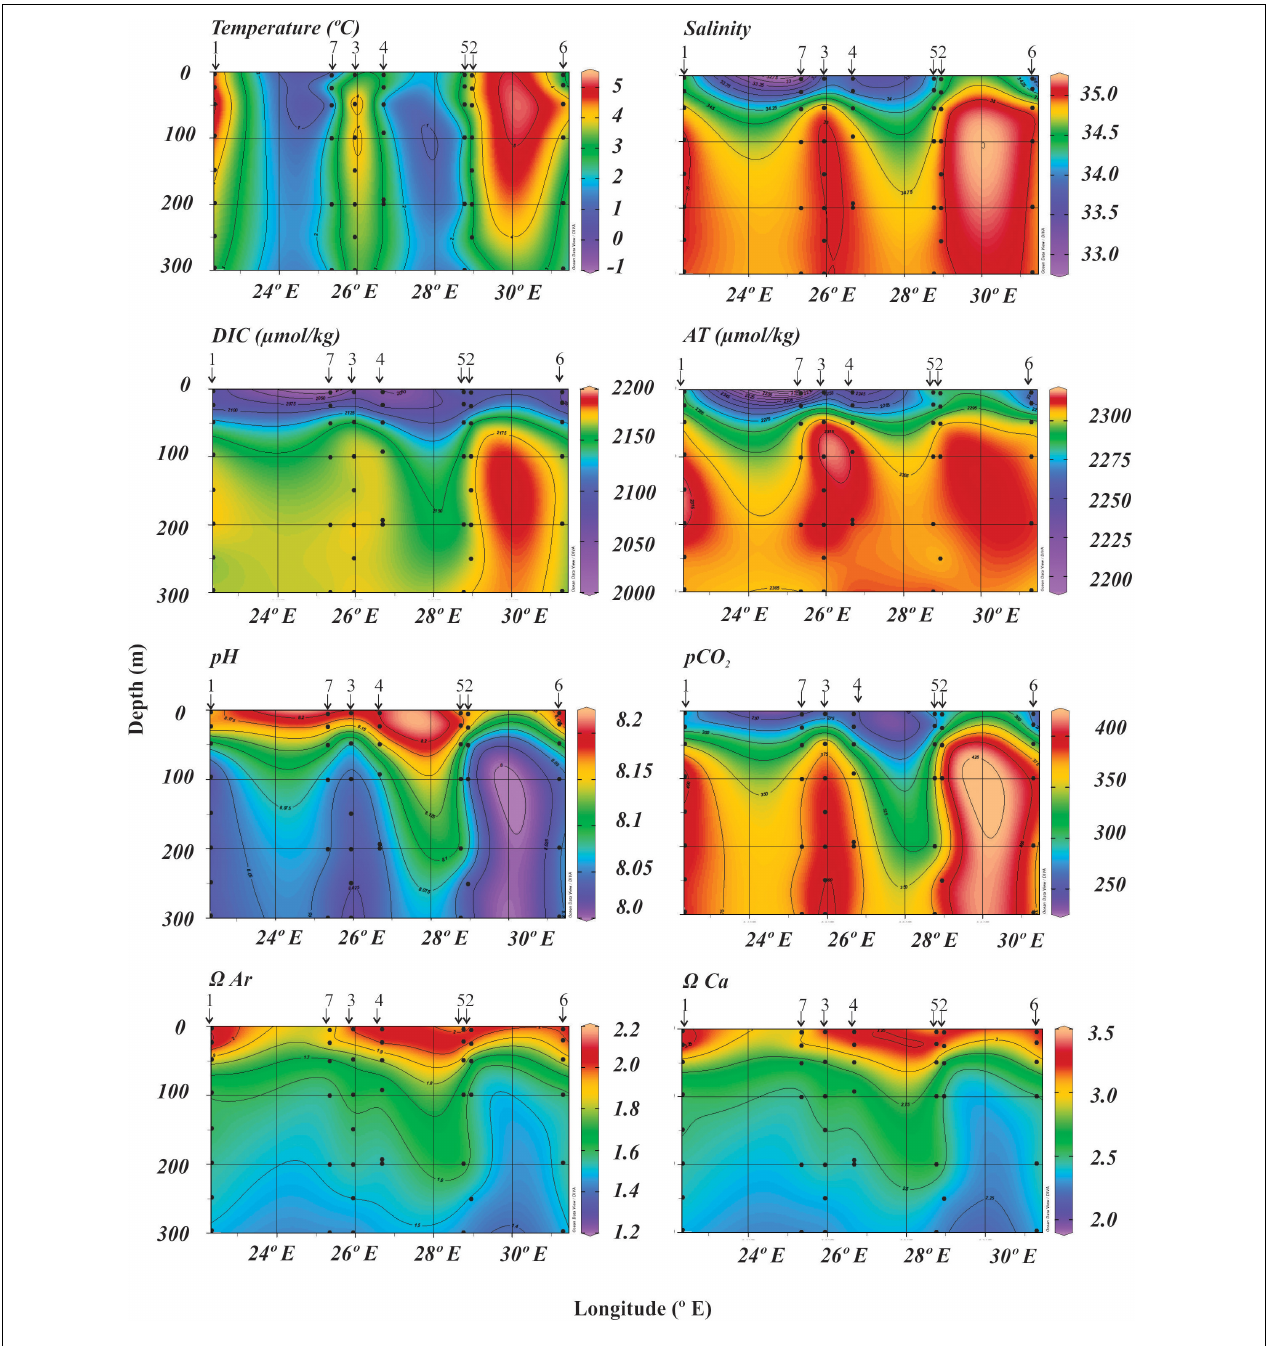
FIGURE 2 | Seawater chemistry sections along the transect. The position of each station represented with black arrows.